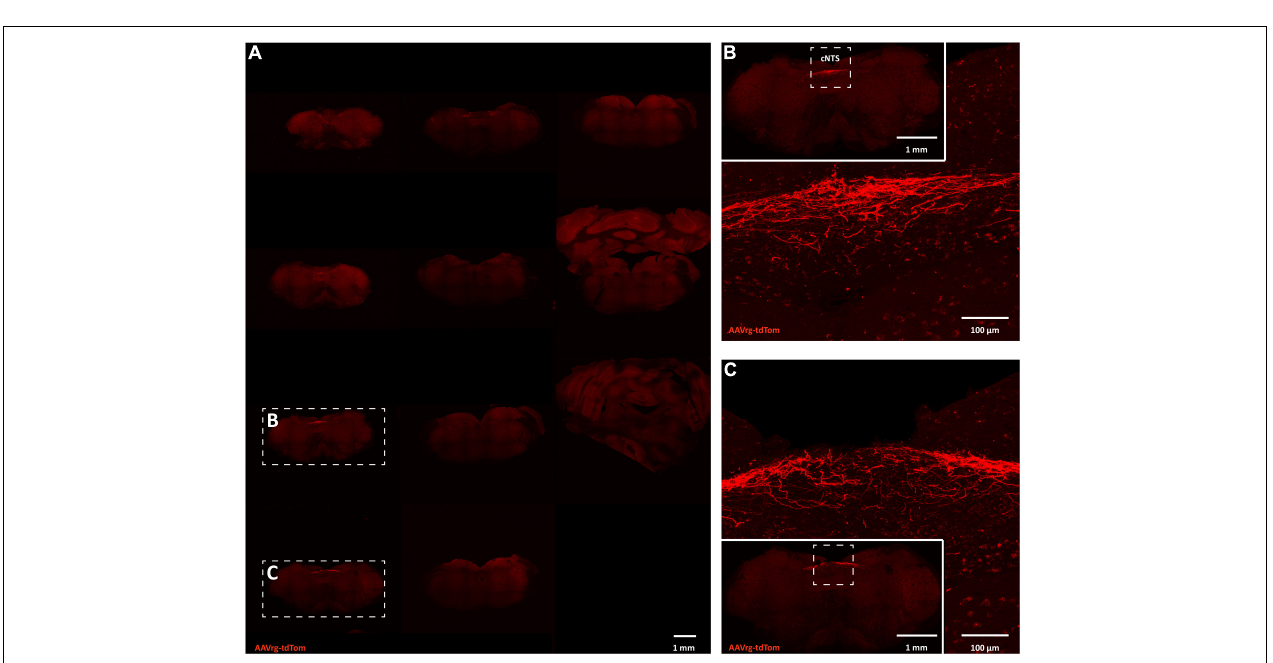
FIGURE 2 | The cell bodies of sensory neurons innervating the aortic arch are in the nodose ganglia of the vagus. (A) A representative photomicrograph of a whole-mount left nodose ganglion (LNG) and right nodose ganglion (RNG) depicting the expression of tdTom within fibers in the vagus nerve and cell bodies of the nodose ganglia ( n = 4). (B) A higher magnification of cell bodies expressing tdTom in the LNG.